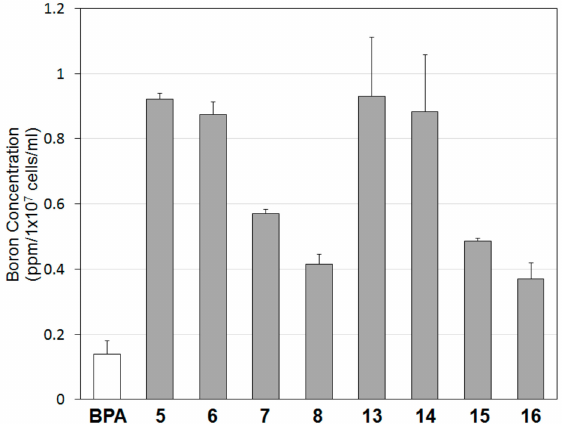
Figure 3. Intracellular boron uptake of compounds 5 – 8 and 13 – 16 . B16 melanoma cells were incubated for 3 h in the presence of each boron compounds or BPA (10 µ M). Then the cells were digested and their boron concentrations were determined by